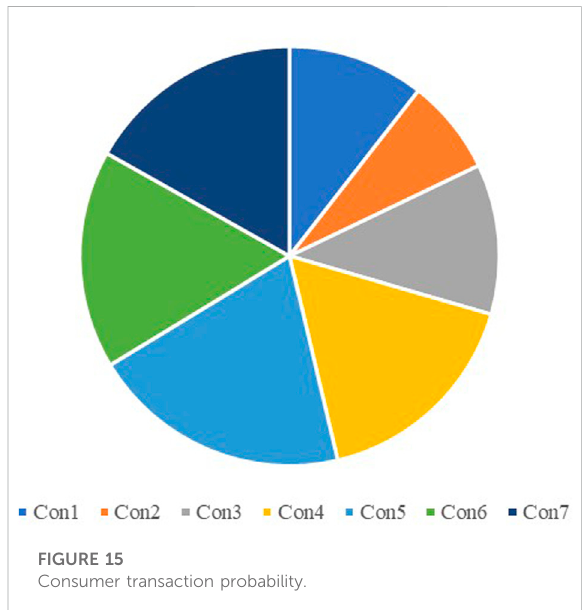
FIGURE 15 Consumer transaction